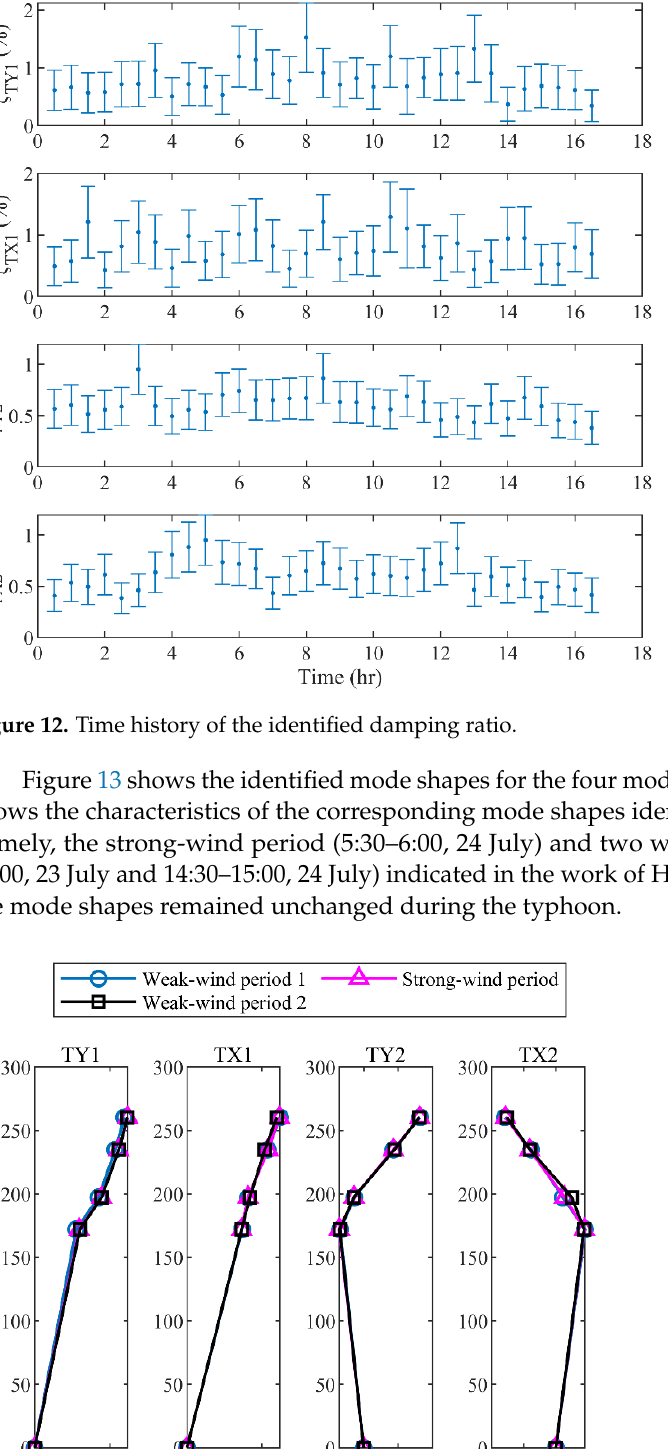
Figure 11. Time history of the identified frequency.